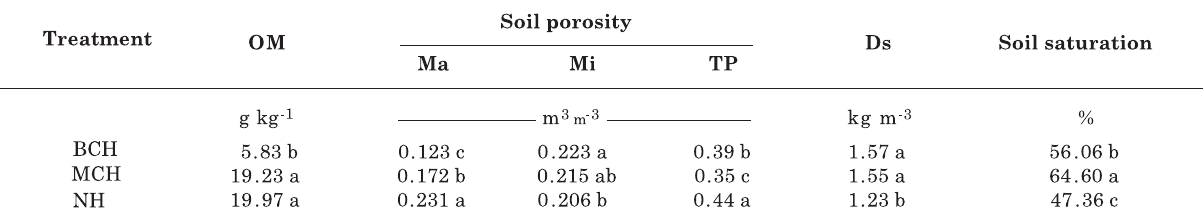
Values followed by the same letter were statistically not different in the Tukey test at 5 %.